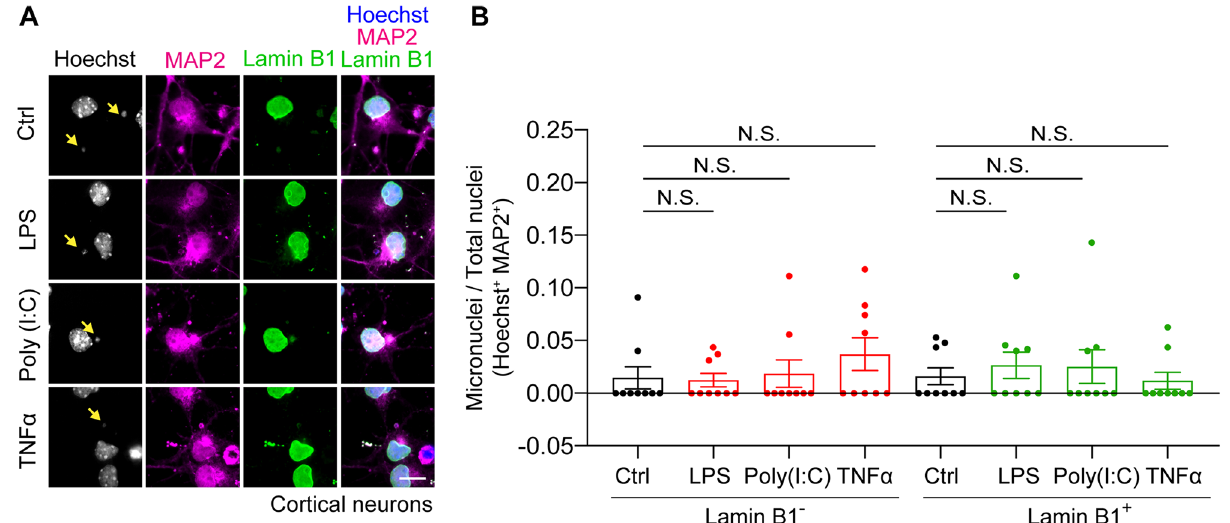
Figure 4. Inflammatory stimulations have little effect on micronuclei formation in neurons in vitro . ( A ) Primary neurons were plated at 1.0 × 10 6 cells in 12-well plate after dissection, and incubated for 4 days. Immunostaining showing the micronuclei formation in the presence or absence of either 1.0 μg/ml LPS, 5.0 μg/ ml Poly (I:C), or 50 ng/ml TNFα for 24 h. Arrows indicate micronuclei. Scale bar: 10 μm. ( B ) The graph shows the population of micronuclei positive neurons. Left columns: Lamin B1 − micronuclei, Right columns: Lamin B1 + micronuclei. The small nucleus (less than 2.0 μm) quantified by CMADi is defined as a micronucleus. n = 9 field; mean ± standard error of the mean (SEM), N.S. not significant by one-way analysis of variance (ANOVA) Tukey–Kramer statical tests. The data were reproduced in two independent experiments. Adobe Creative Could CC (Photoshop 22.1.0 and Illustrator 25.0.1) (https:// www. adobe. com/) was used for all image processing in Fig.